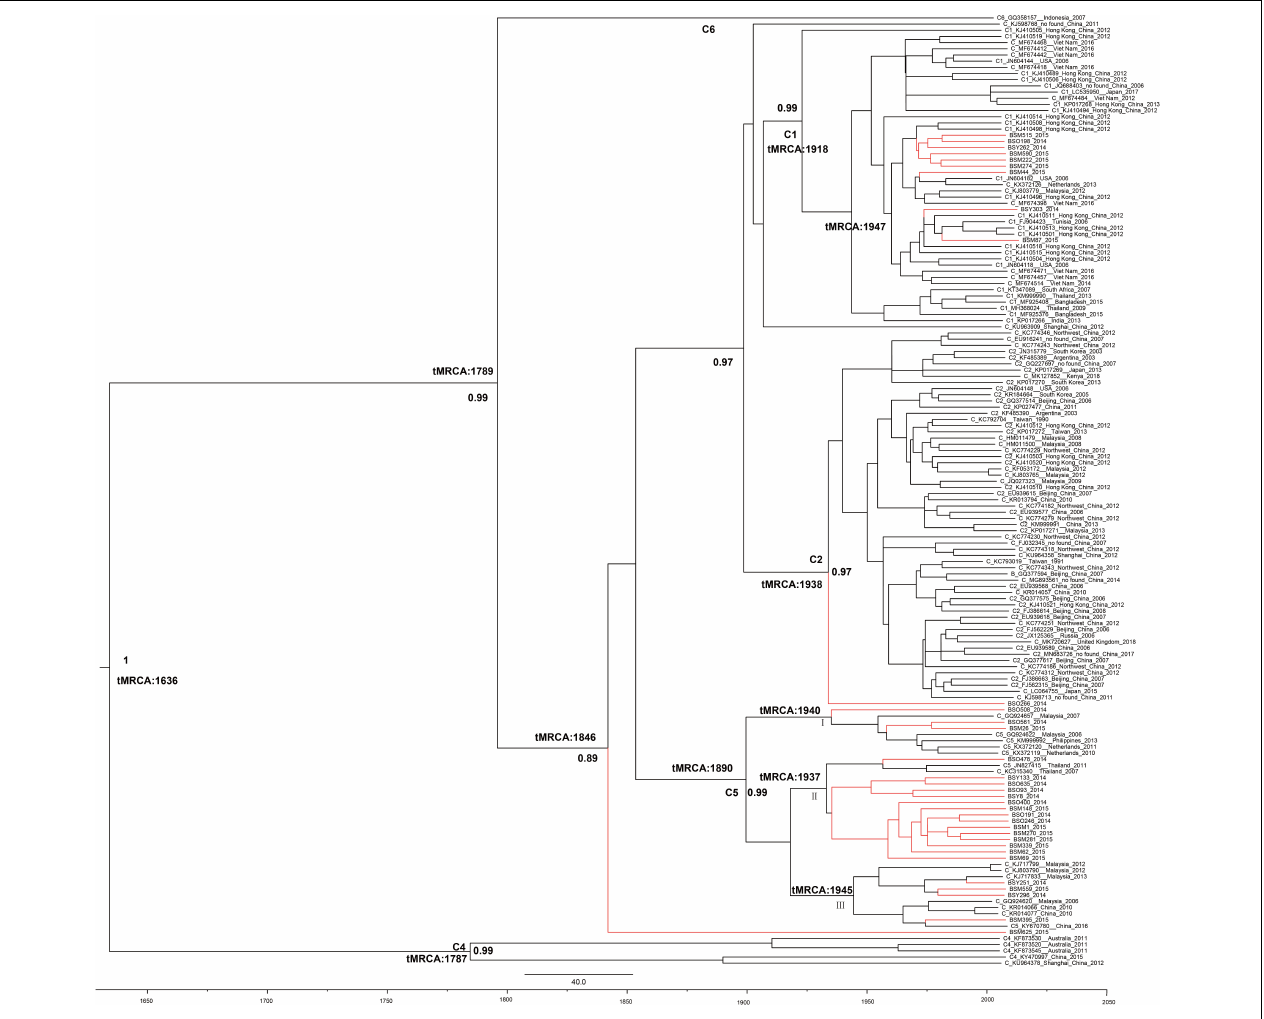
FIGURE 3 | Bayesian maximum clade tree of HBV-C partial P region sequences. Branches of Baisha sequences are colored red. The scale at the bottom of the tree represents years before the last sampling time (2015). All nodes marked with an asterisk show a posterior probability > 0.90. The tree was automatically rooted under the assumption of a relaxed molecular